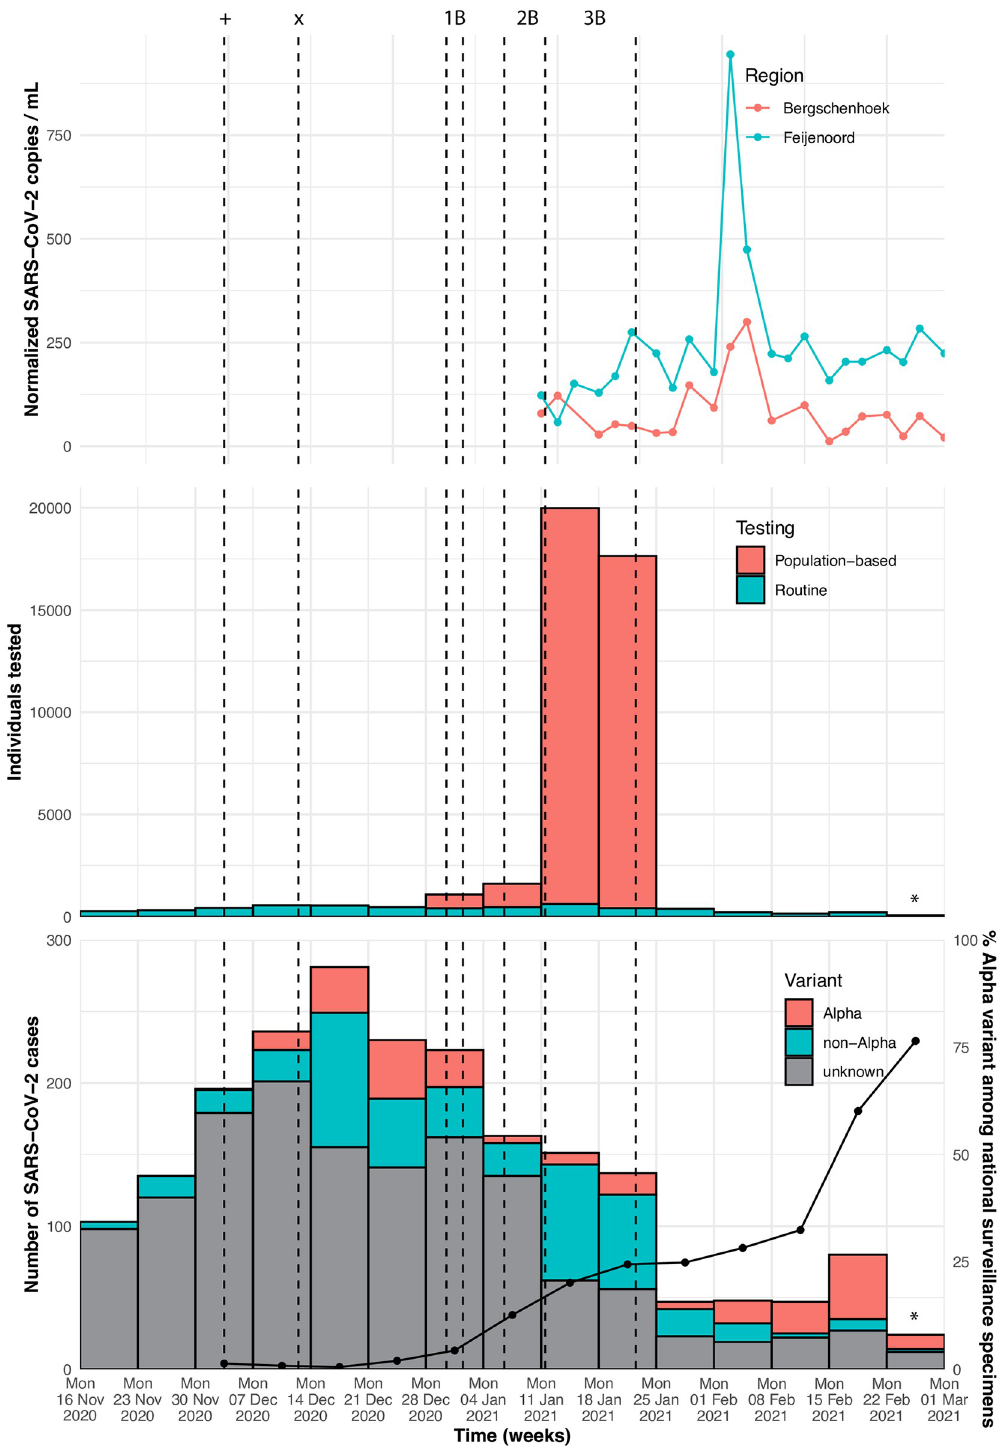
Fig 3. Number of confirmed SARS-CoV-2 cases per week in Lansingerland (including individuals with an epidemiological link to School X or neighbouring schools) by variant (bottom). Line shows the percentage of Alpha variant among national surveillance specimens per week on the right y-axis (data obtained via https://www.rivm.nl/coronavirus-covid-19/virus/ varianten) (bottom). Number of individuals tested for SARS-CoV-2 in Lansingerland (including individuals with an epidemiological link to School X or neighbouring schools) (middle). Levels of normalized SARS-CoV-2 copies per mL of